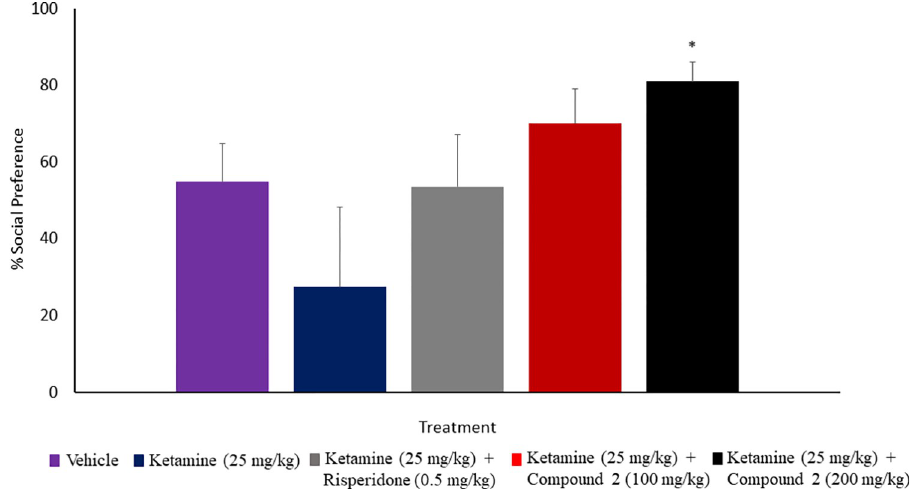
Fig 5. Effect of compound 2 on ketamine-induced social isolation. Rats were injected with ketamine for 10 days, then left undisturbed for 3 days. On day 14th, vehicle, risperidone or compound 2 was administered, and rats were tested for social preferences. Rats treated with 200 mg/kg compound 2 showed a significant increase in % social preference than rats treated with ketamine. Data are expressed as a mean ± S.E.M (n = 8–12) and analysed by One-way ANOVA followed by Tukey’s post hoc test, � p < 0.05 compared to the schizophrenia control group.